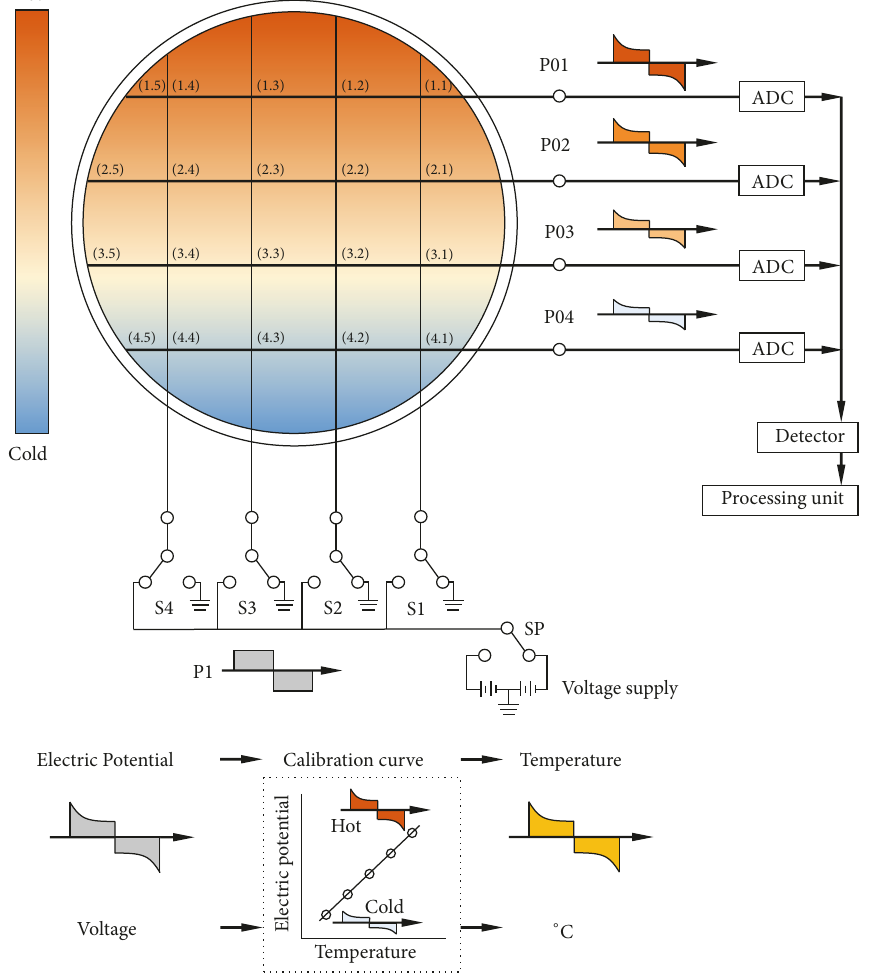
Figure 1: Principle of the temperature profile sensor and its signal processing